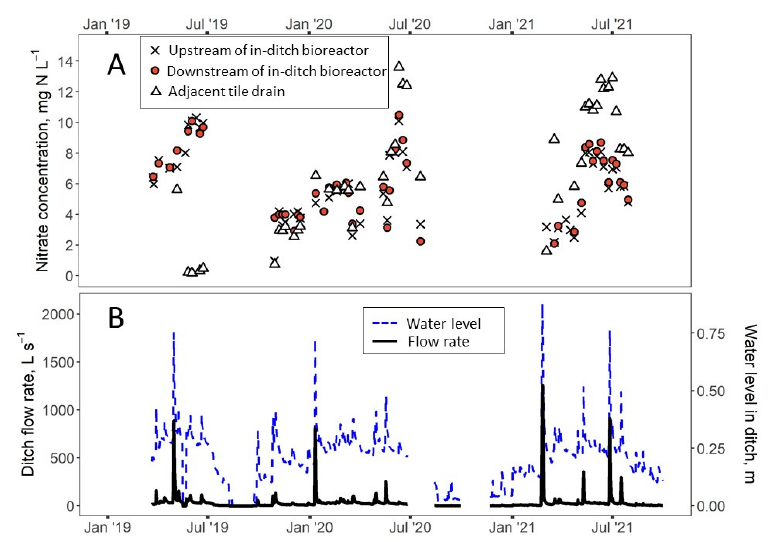
Figure 2. Nitrate concentrations upstream (black × ) and downstream (red circle) of the in-ditch bioreactor ( A ). Estimated flow rate (solid black line) and water level (dashed blue line) in the ditch, measured at the cinder block weir ( B